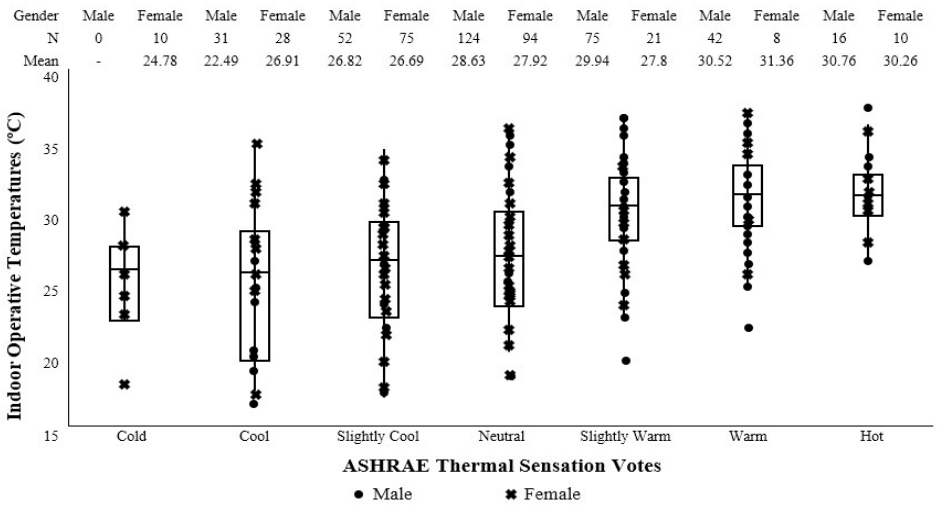
Figure 1. Boxplots and dot plots of the seven-point thermal sensation scale ASHRAE, with a statistical summary of indoor air temperatures ( ◦ C) related to ASHRAE votes filtered by gender on the top. Adapted from ref. [22]. 2020, the authors.